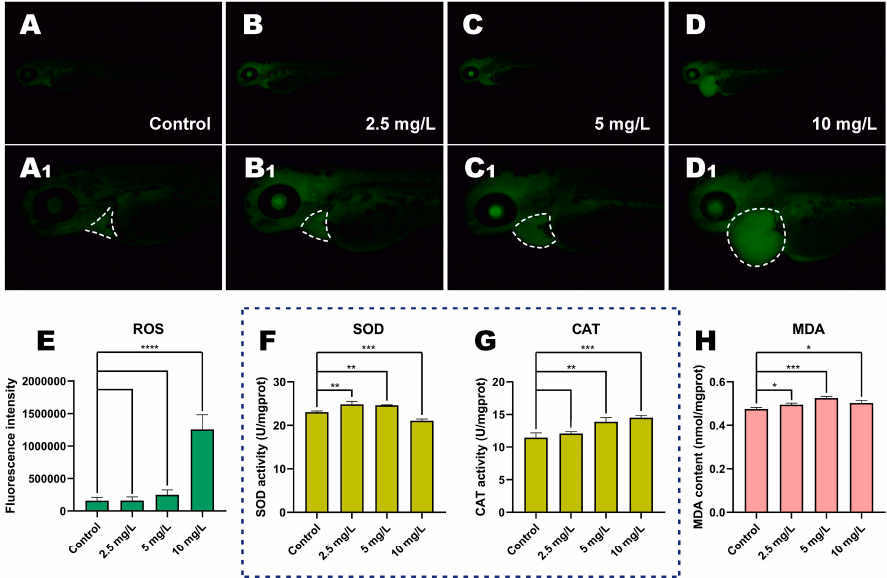
Figure 4. MP induces oxidative stress in zebrafish embryos. ( A – D ) The fluorescence distribution of ROS in embryos is presented when exposed to different concentrations of MP, where ( A1 – D1 ) indi- cate the magnified images of A, B, and C, respectively. The white dashed area represents the posi- tion of the heart after staining. ( E ) Relative fluorescence intensity of ROS. ( F ) Enzymatic activities of SOD. ( G ) Enzymatic activities of CAT. ( H ) Content of MDA. (mean ± SD, n = 3, ANOVA, post hoc Dunnett’s multiple comparison test, * p < 0.05, ** p < 0.01, *** p < 0.001, **** p <